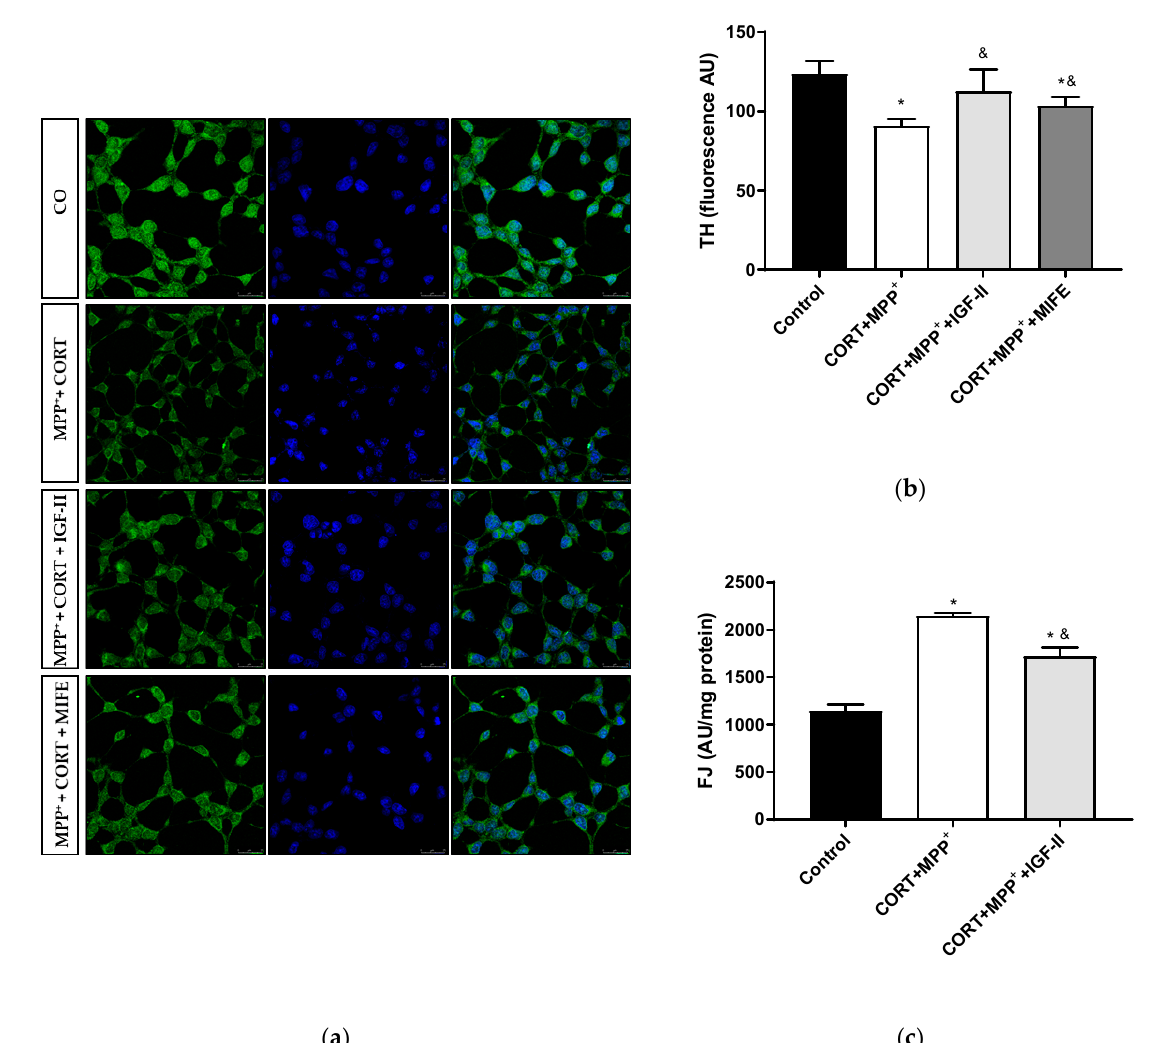
Figure 5. Study of dopaminergic marker and neurodegeneration in SN4741 neuronal cells after incubation with the combination of corticosterone and MPP + (CORT + MPP + ) in the presence or absence of IGF-II. ( a ) Representative immunocytochemistry stain for DAPI and TH; ( b ) Quantification of TH immunofluorescence; ( c ) Neurodegeneration evaluated as FJ fluorescence intensity. Representative images (63X). CO: control cells. Data from three independent experiments were combined and presented as mean ± SEM. * p < 0.05 compared to control cells; & p < 0.05 compared to CORT + MPP + co-incubated cells.